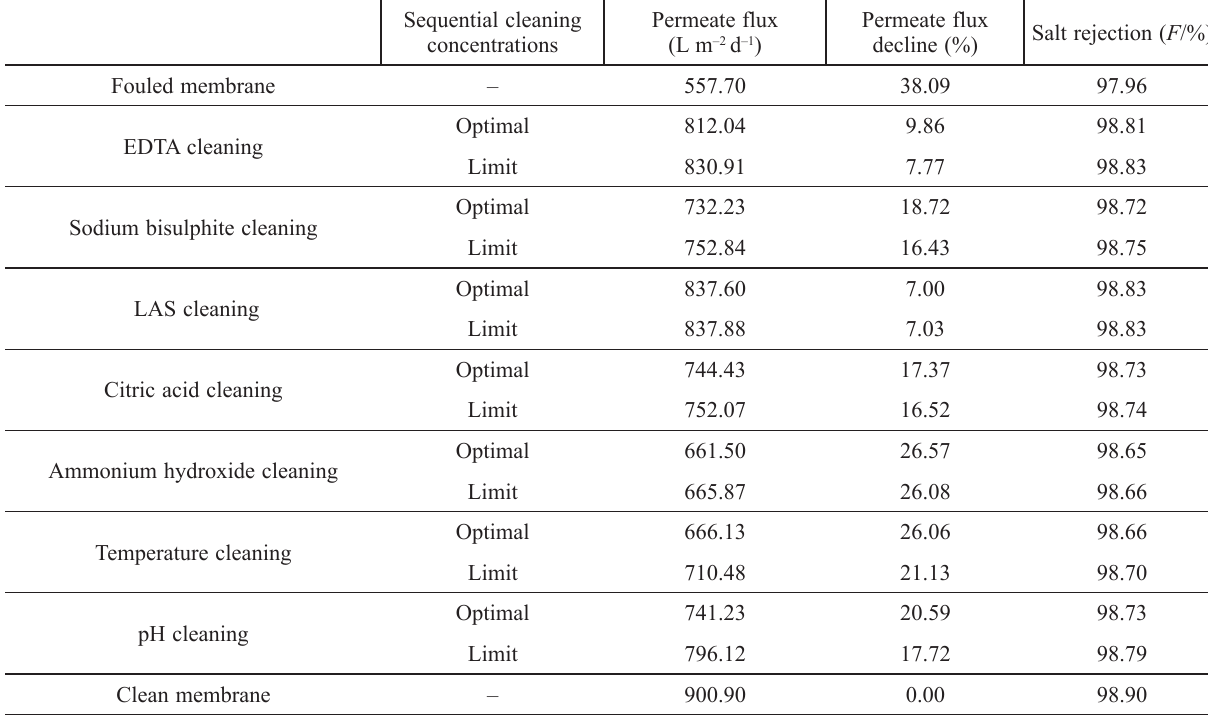
Table 5 – Comparison of the permeate flux and salt rejection values obtained in the cleaning trials with single cleaning reagents for the values considered as optimal and limit concentrations Sequential cleaning